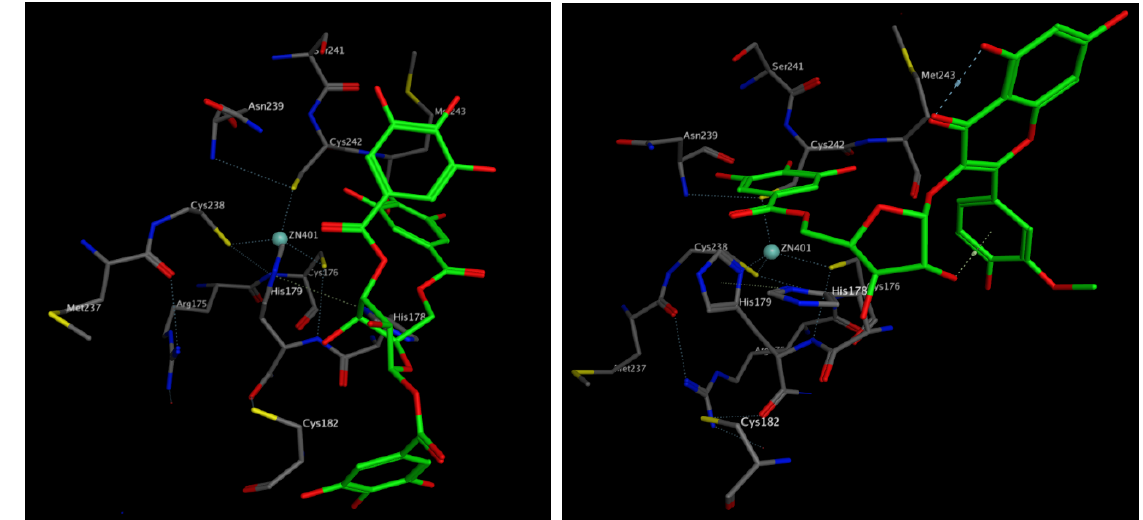
Figure 20. Amino acid interactions with trigalloyl glucose ( left ) and isorhamnetingalloyl- pentoside ( right ) in the DNA binding domain of p53.